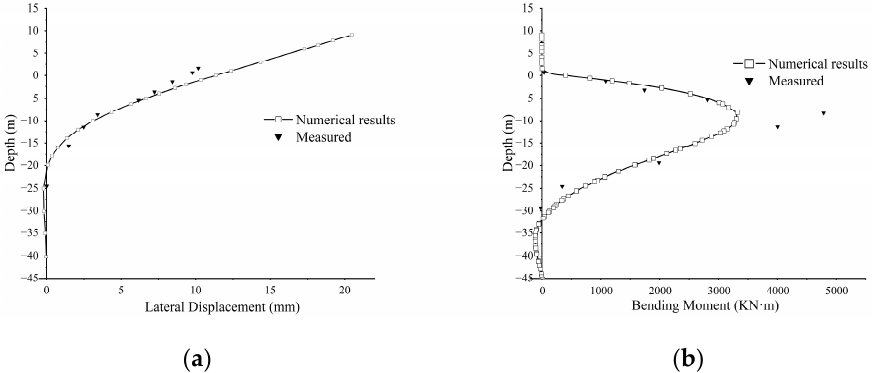
Figure 2. Computed and measured response of bored pile ( a ) Depthlateral displacement ( b ) depth- bending moment.